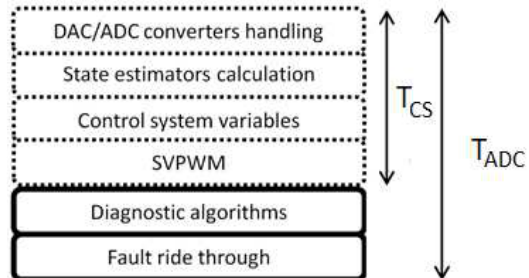
Figure 1. Integrated control system and fault diagnostic algorithms between ADC interrupts of the microcontroller.